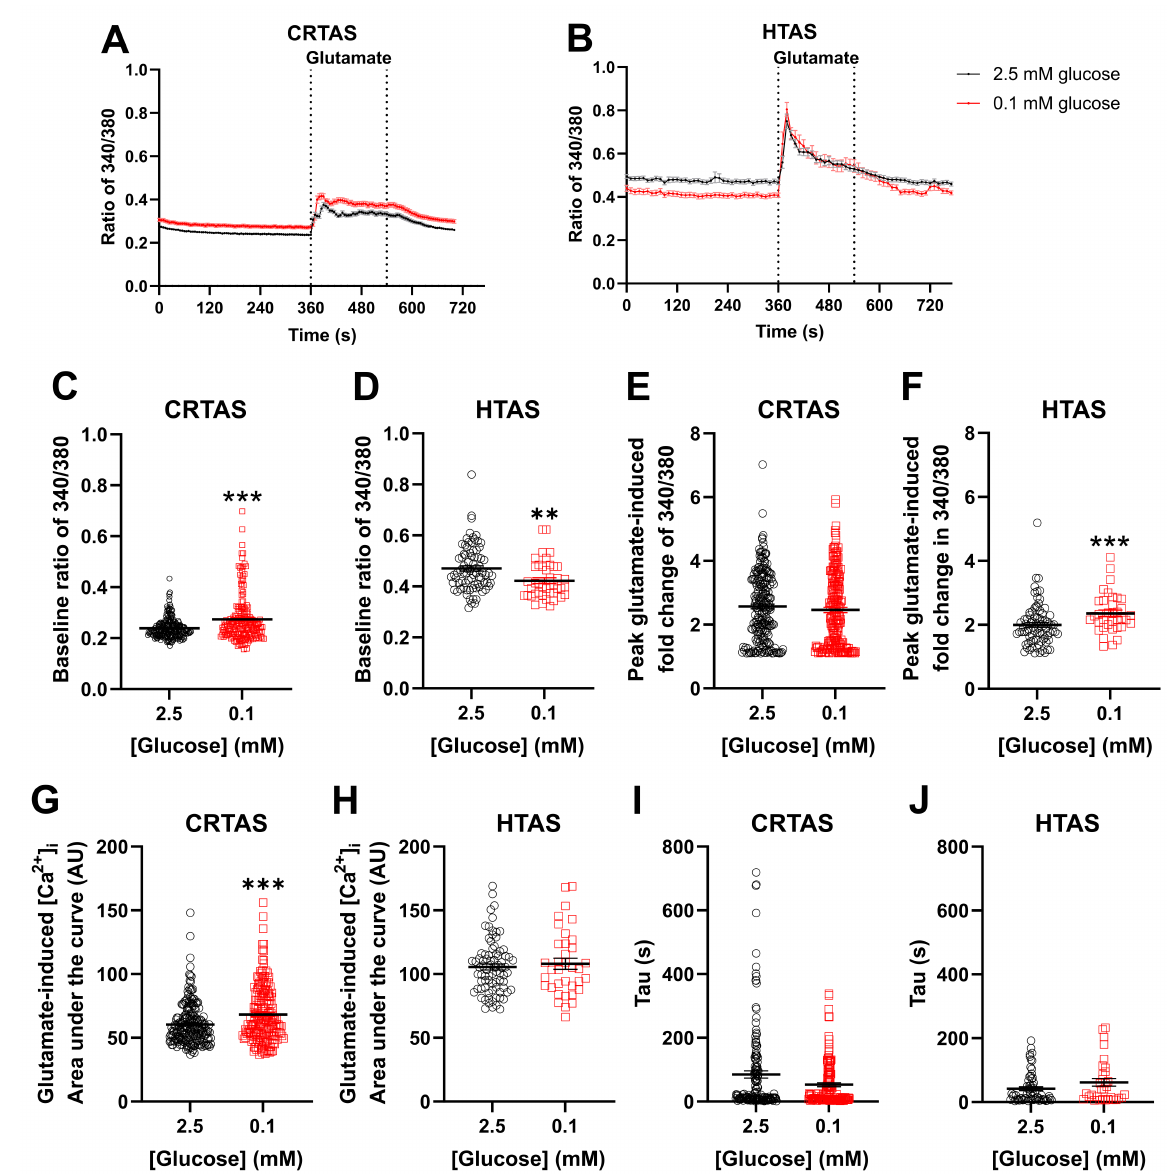
Figure 1. Prior low glucose increases and decreases average basal calcium in cortical and hypotha- lamic astrocytes respectively. Primary cortical (CRTAS) and hypothalamic (HTAS) astrocytes were loaded with Fura-2 calcium sensitive dye for 1 h in either normal (2.5 mmol/L; CRTAS n = 211 across 13 coverslips; HTAS n = 81 across 8 coverslips, open black circles) or low (0.1 mmol/L; CRTAS n = 186 across 12 coverslips; HTAS n = 42 across 6 coverslips, open red squares) glucose containing normal saline before imaging begun. Intracellular calcium concentration was determined as the ratio of fluorescence emission at 505 nm when stimulated at 340 nm and 380 nm. After 6 min 100 µ mol/L glutamate was added for 3 min before washout and termination of imaging. Intracellular calcium levels of CRTAS ( A ) and HTAS ( B ). Baseline ratio of 340/380 in CRTAS ( C ) and HTAS ( D ). Peak glutamate-induced fold change in ratio of 340/380 of CRTAS ( E ) and HTAS ( F ). Glutamate-induced area under the curve in CRTAS ( G ) and HTAS ( H ). Tau, the decay of the glutamate signal, in CRTAS ( I ) and HTAS ( J ). Mann–Whitney tests. Kruskall-Wallis tests with post hoc Dunn’s tests. Two-Way ANOVA with post hoc Dunnett’s multiple comparisons test. ** p < 0.01; *** p <